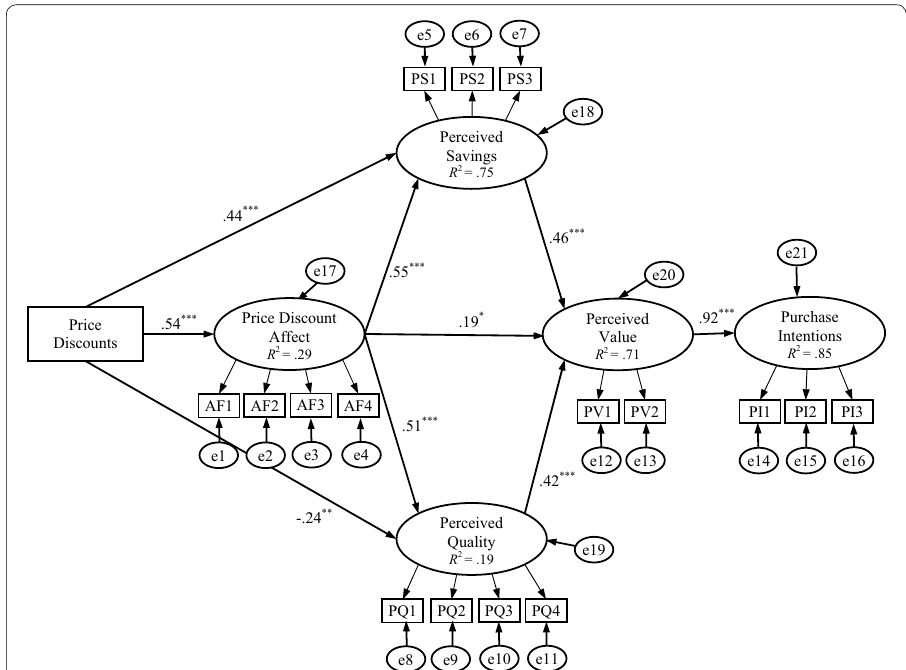
Fig. 2 Structural model and hypothesis testing results. All path coefficients are standardized estimates; *p .05, **p .01, ***p ≤ ≤ ≤